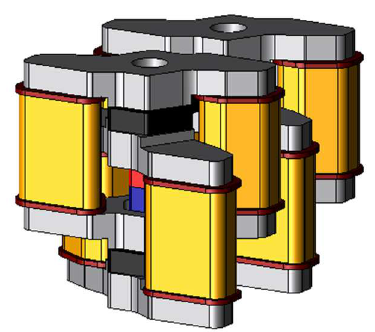
Figure 4. Structure of the two-parallel